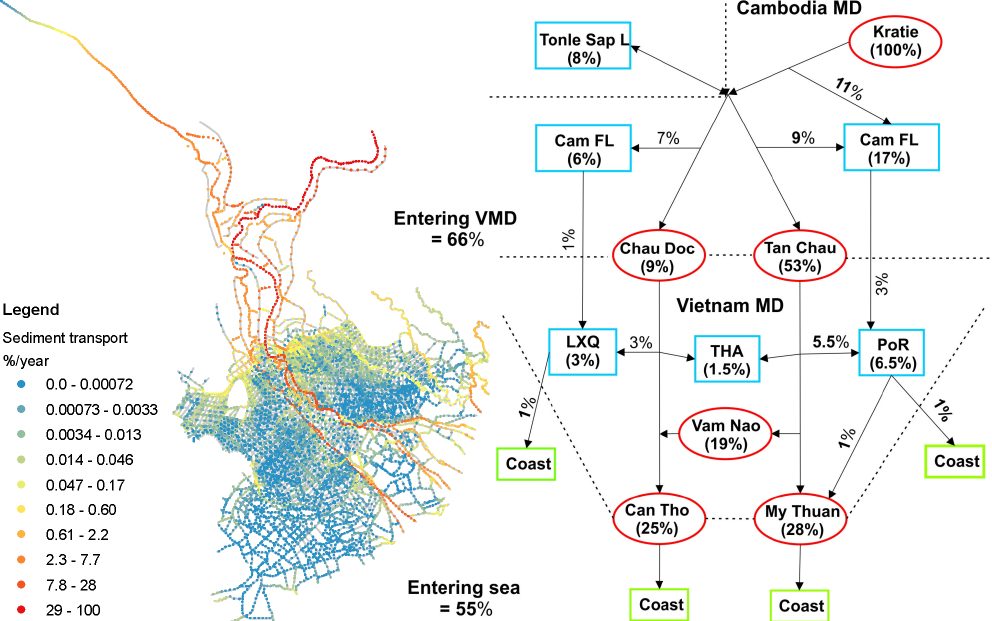
Figure 7. Proportion of transported sediment in the whole MD compared to sediment load at Kratie (left panel), and sediment load transport into subsystems (blue squares) and to key stations (red circles), both for the normal flood year